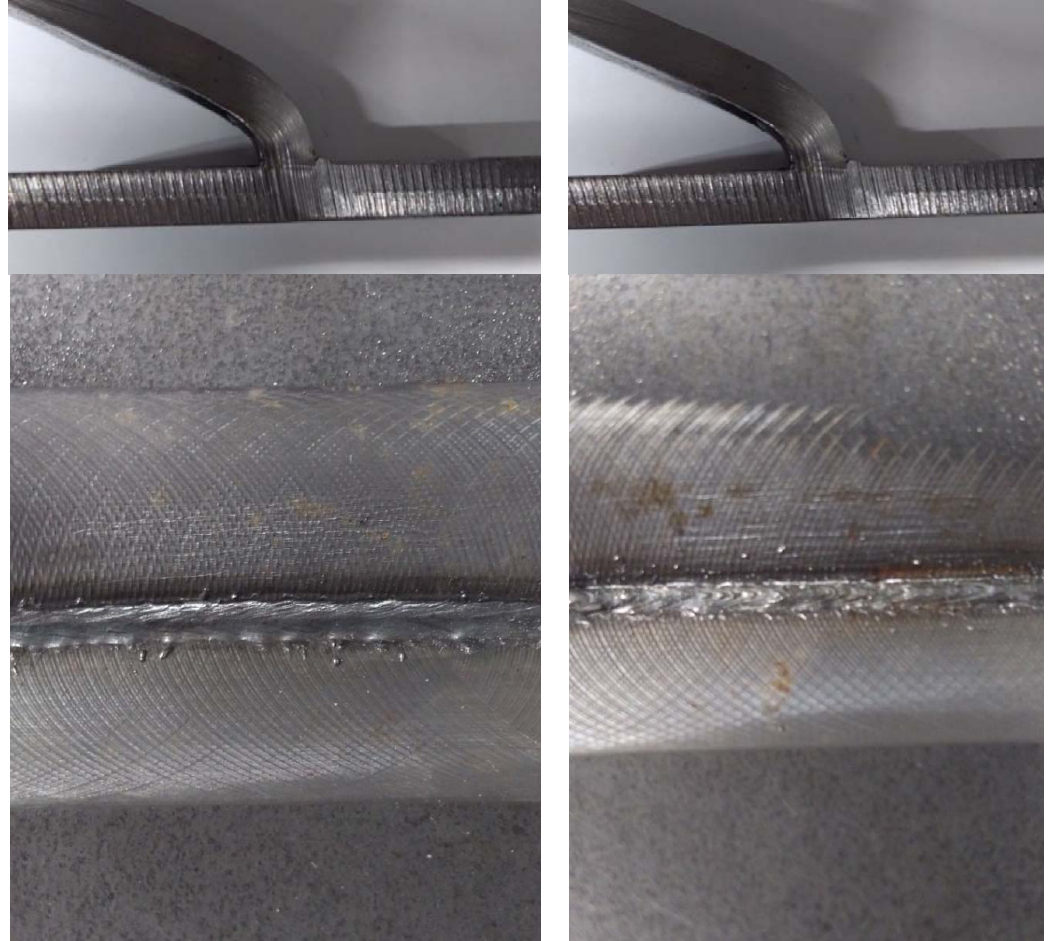
Key: l—length of a welding imperfection (measured in any direction), h—dimension of a welding imperfection (height, width), t—thickness of an element subjected to welding, f—gas pore or gas cavity projection areas. Calculations: h = 500 μ m = 0.5 mm, t = 10 mm. 0.5 mm ≤ 0.3 × 10 mm, 0.5 mm ≤